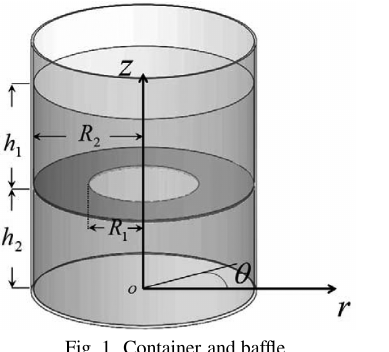
Fig. 1. Container and baf fl e. Fig. 2. Sub-domains and